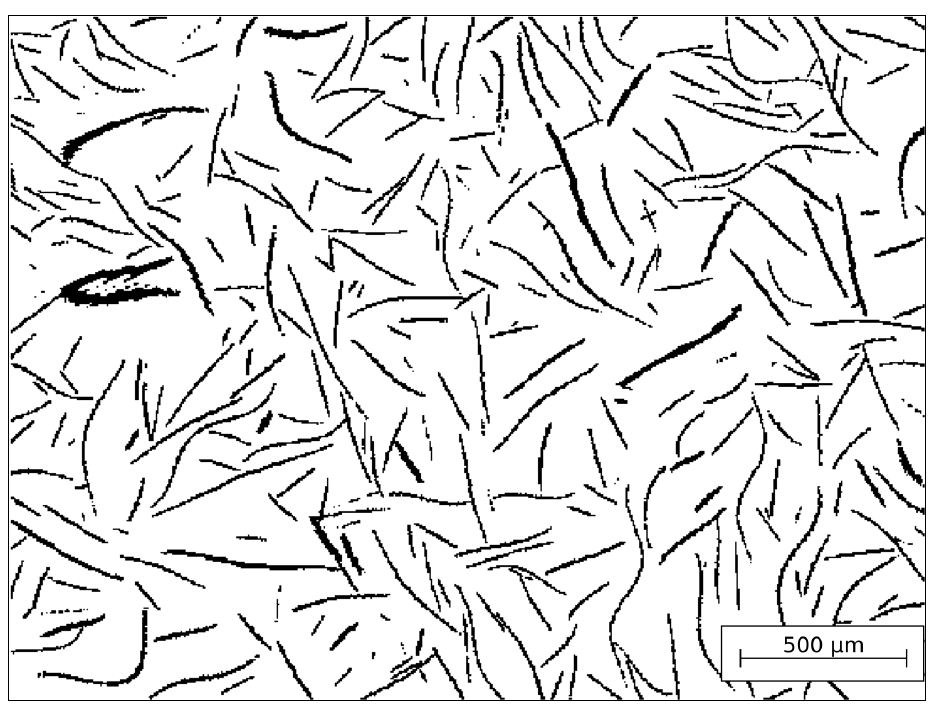
Figure 2. “Micrograph” of a synthetically generated GJL-150 material, with a graphite flake volume fraction of 10v. %. −